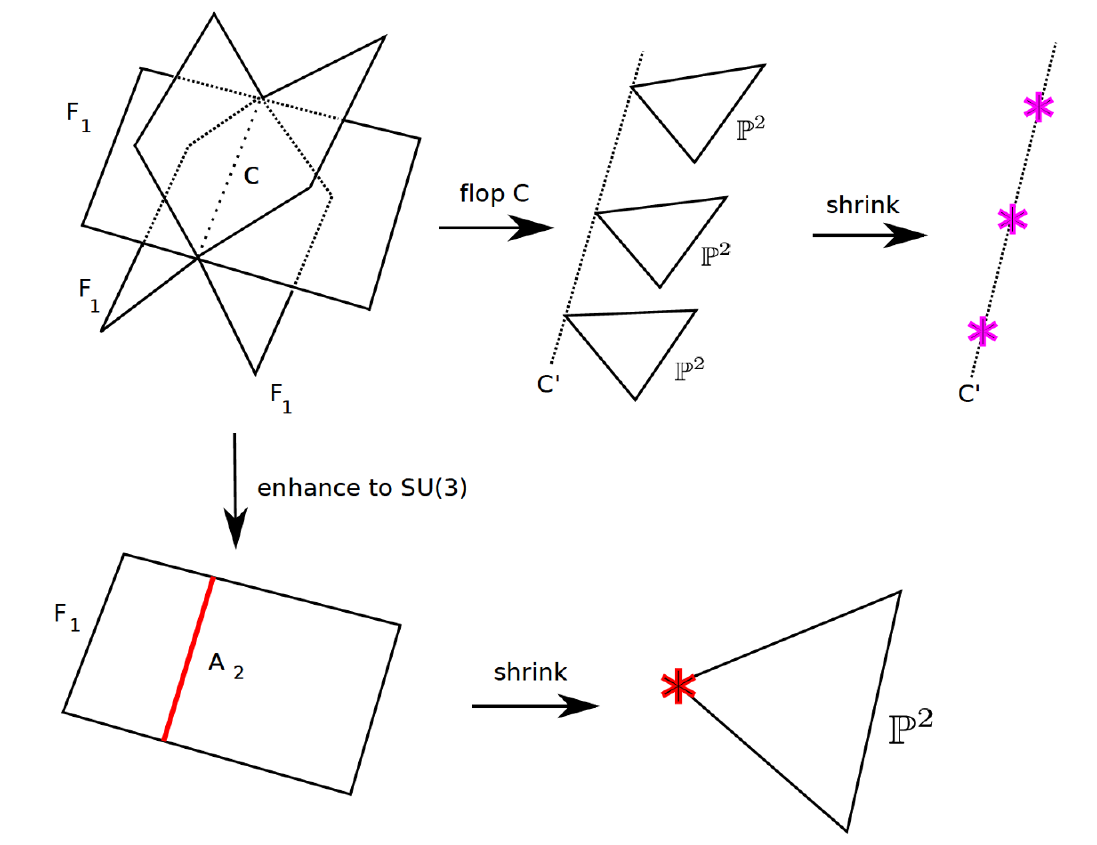
Figure 2 . Geometry of the (cid:0) 3 theory. upper left : reduction of the tensor branch over S 1 ; upper center : (cid:13)op phase transition; upper right : reduction of the 6D SCFT over S 1 ; lower left : gauge symmetry enhanced to SU(3); lower right : strong coupling limit of SU(3) theory. In the 5D limit, C 0 and P 2